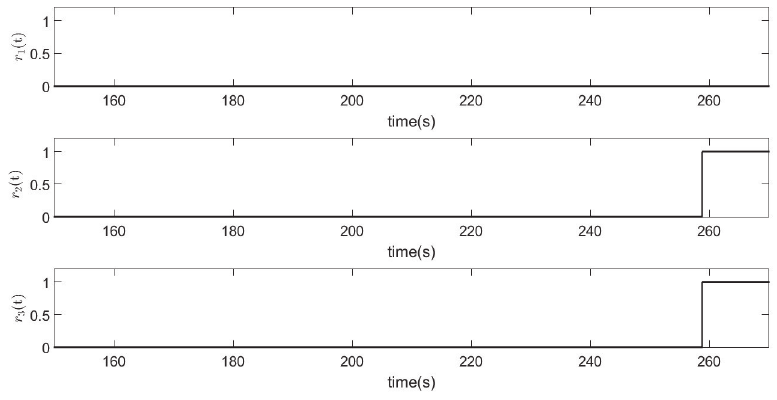
Figure 10. Normalized residual evaluation in case 3 (fault at sensor 2, f s 2 ).